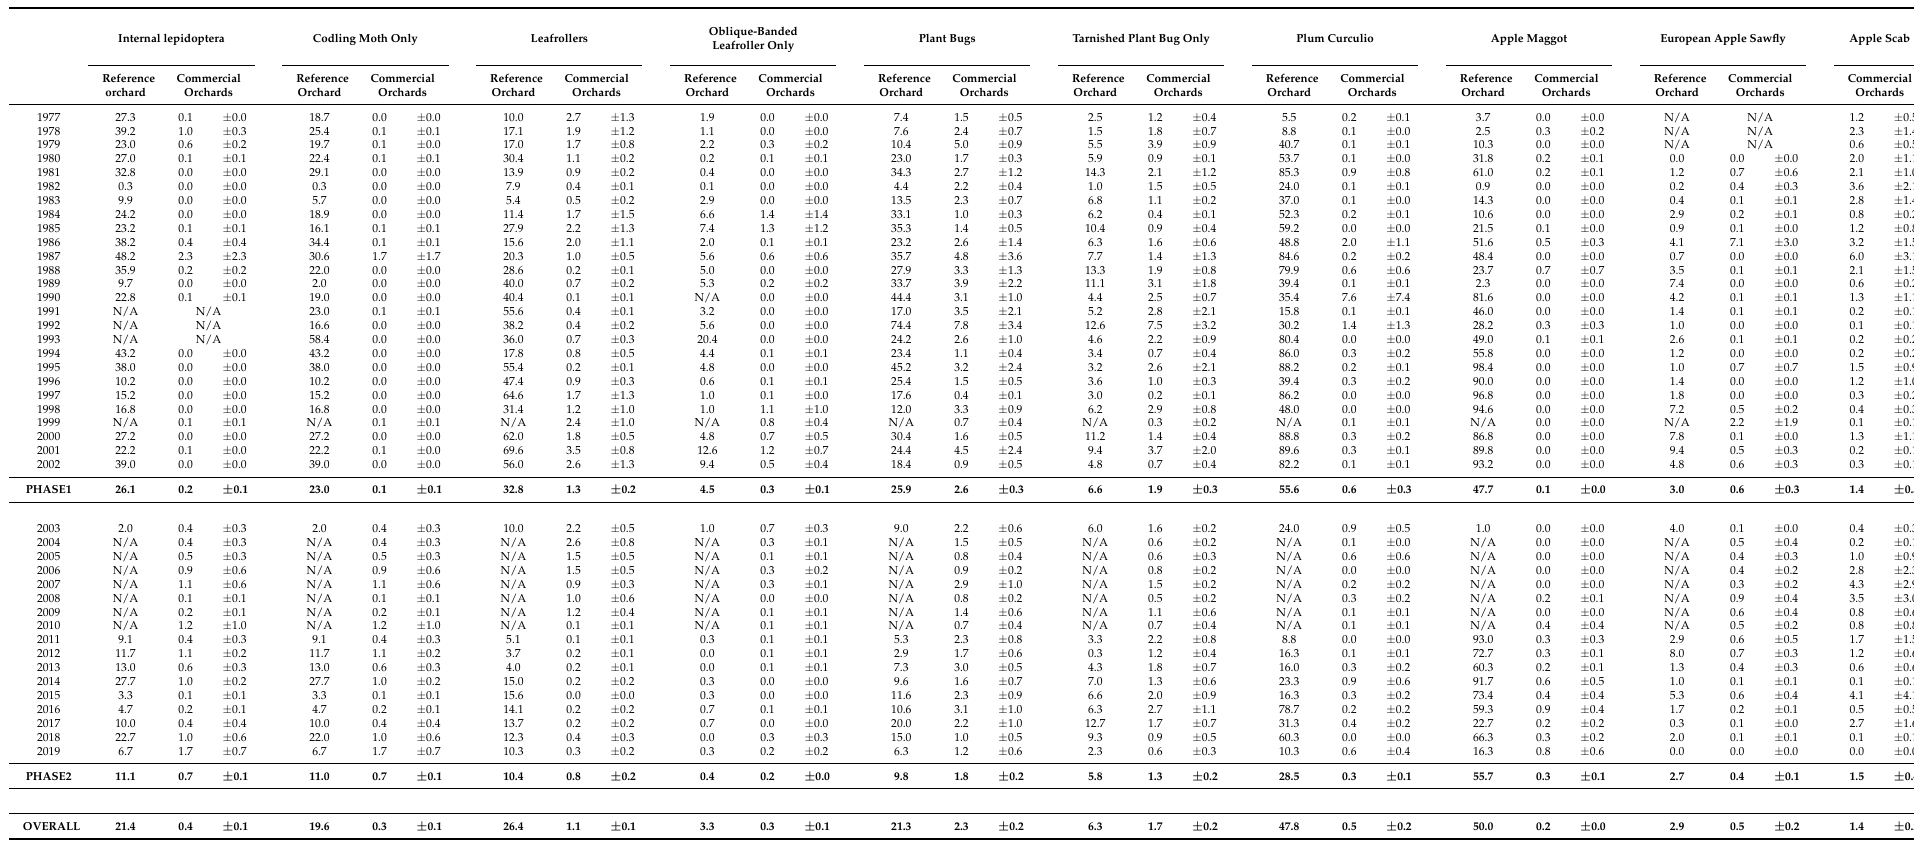
Table 2. Percent damage caused to fruit at harvest in participating orchards (1977–2001: n = 1000 fruits; 2002-2019: n = 500 fruits). Reference (insecticide-free) orchard located at Frelighsburg, Qc (Agriculture and Agri-Food Canada, 1977–2002) and Saint-Bruno-de-Montarville from 2003 to 2019. Commercial orchards located at Franklin, Hemmingford, Oka, Rougemont and Saint-Paul d’Abbotsford. PHASE1: average from 1977–2002. PHASE2: average from 2003–2019. OVERALL: average from